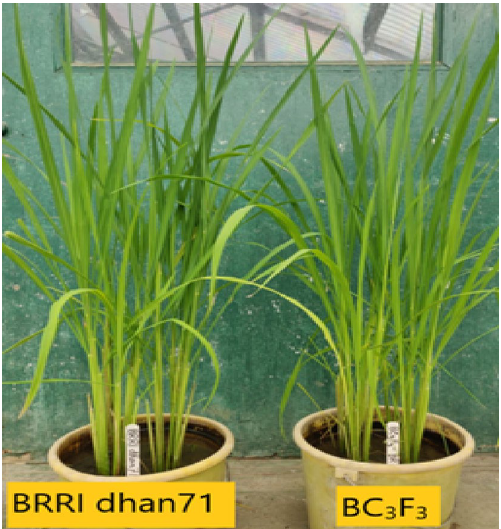
Figure 2. Introgression line with tsv1 gene and recipient parent BRRI dhan71.